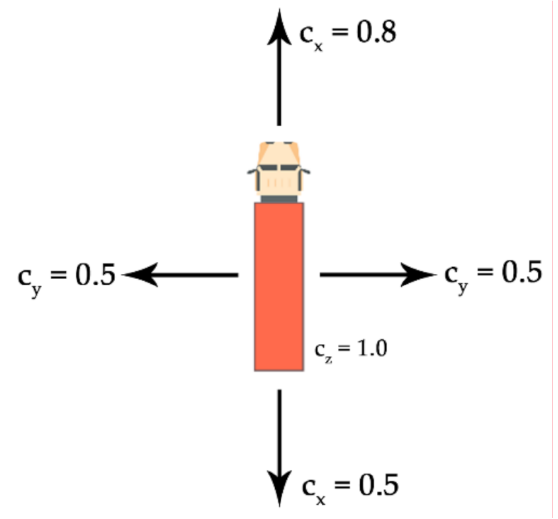
Figure 2. Illustration of applicable acceleration coefficients for road transport